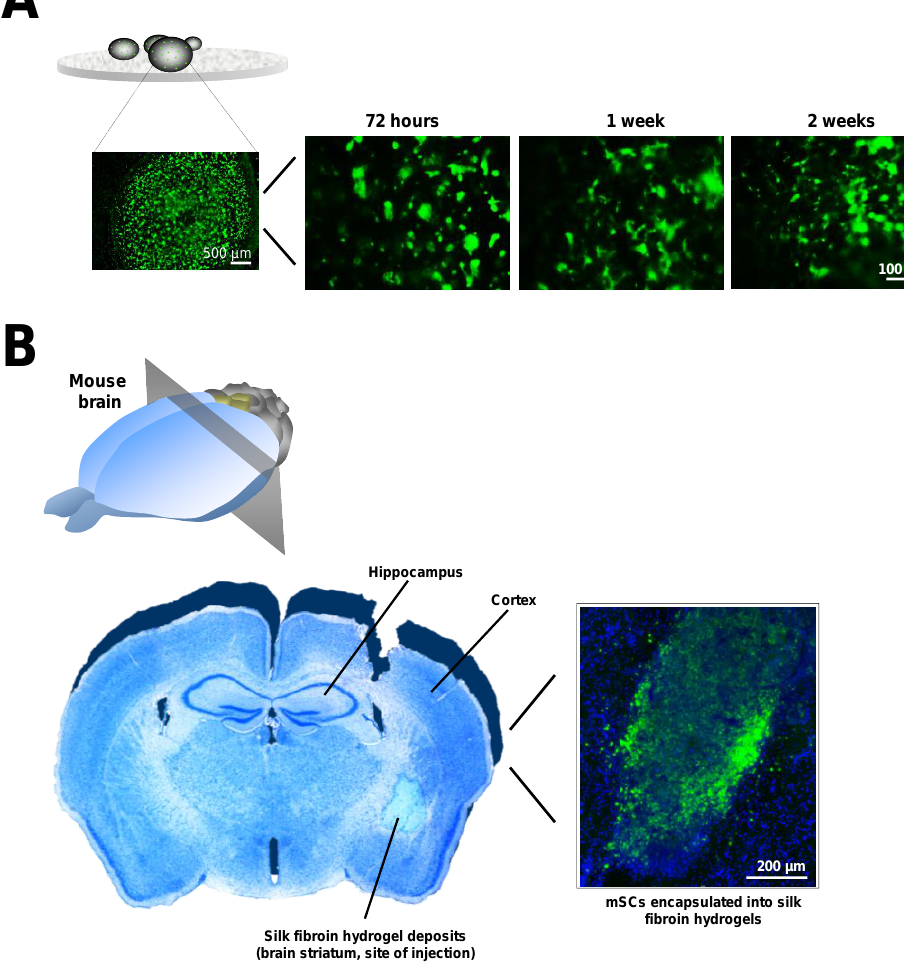
Figure 4. Stem cell engraftment assisted by silk fibroin-based hydrogels. ( A ) Positive staining for calcein (vital dye) showing how a specific stem cell population of mesenchymal origin (mSCs) survives in vitro integrated into silk fibroin hydrogel droplets during a two-week study period. ( B ) In vivo mSCs engraftment in the mouse brain is enhanced by the inclusion of this cell population into silk fibroin hydrogels [249]. Implantation of mSCs expressing the Enhanced Green Fluorescent Protein (EGFP) was done in the brain striatum of non-EGFP mice. In the figure, nuclei were stained with Hoechst (pseudocolor blue). It is known that the EGFP antigen might trigger an immunological response causing the loss of EGFP-cells in a non-EGFP brain microenvironment. However, the small pore size of silk hydrogels (~100 – 200 nm) seems to constitute a barrier to attenuate the immuno-attack of resident immune cells against the transplanted EGFP-mSCs. This barrier may also contribute to isolate and protect the engrafted mSCs from a hostile microenvironment as is the brain tissue after injury. Thus, this silk fibroin hydrogel favors the retention and survival of mSCs in the brain striatum for up to four weeks after transplantation (period examined in the image shown), a time frame that goes beyond the lifespan seen with different types of SCs engrafted without a biomaterial scaffold.